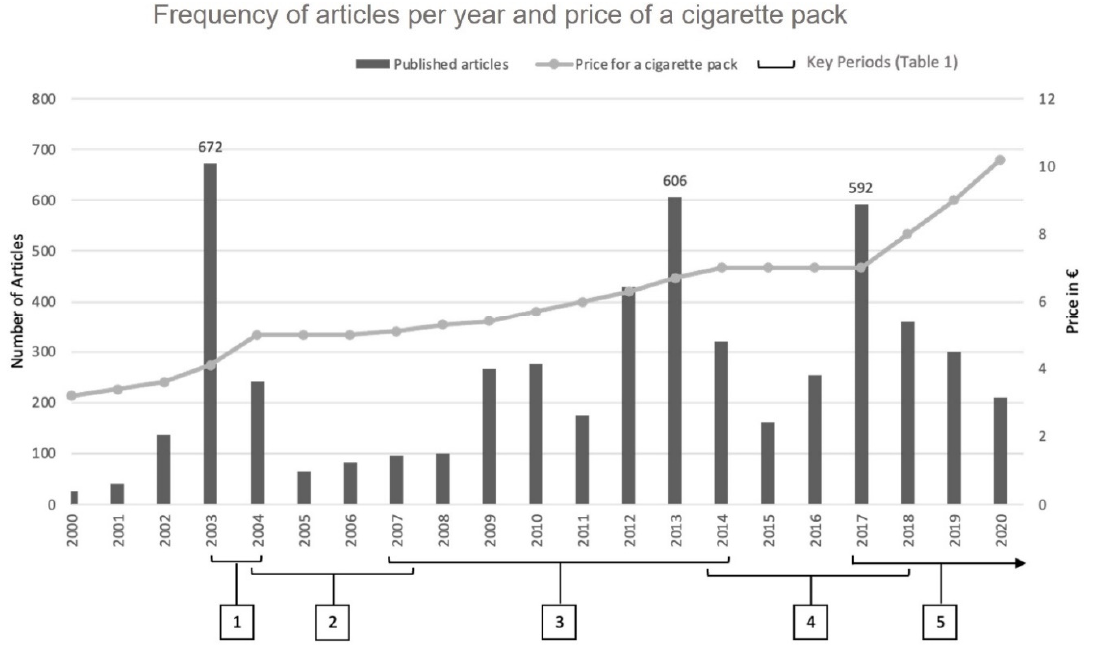
Figure 2. Number of articles per years with regard to tobacco price increases and with the 5 key periods of taxation policies in France between 2000 and 2020 ( n = 5409). Key Periods source: Table